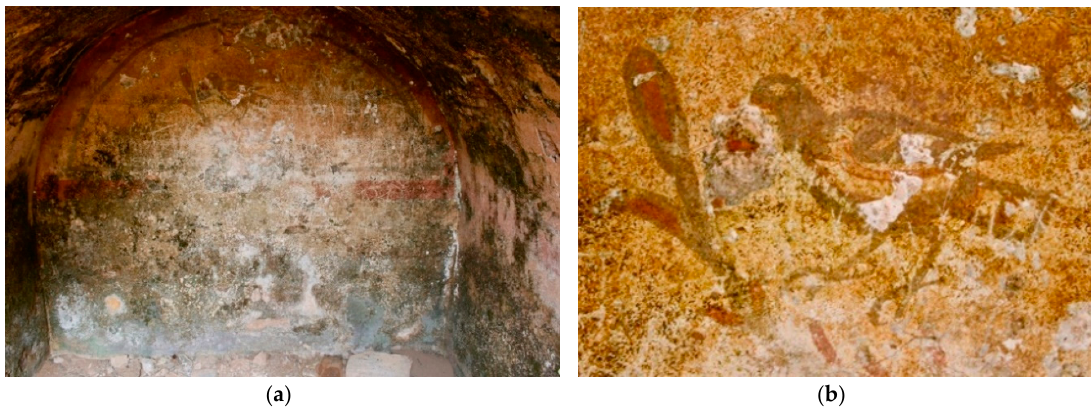
Figure 25. Sardis, Artemis precinct tomb (Tomb AT 2, Appendix A.10), west wall. ( a ) Longshot; ( b ) detail of bird in lunette. © Archaeological Exploration of Sardis/President and fellows of Harvard College.